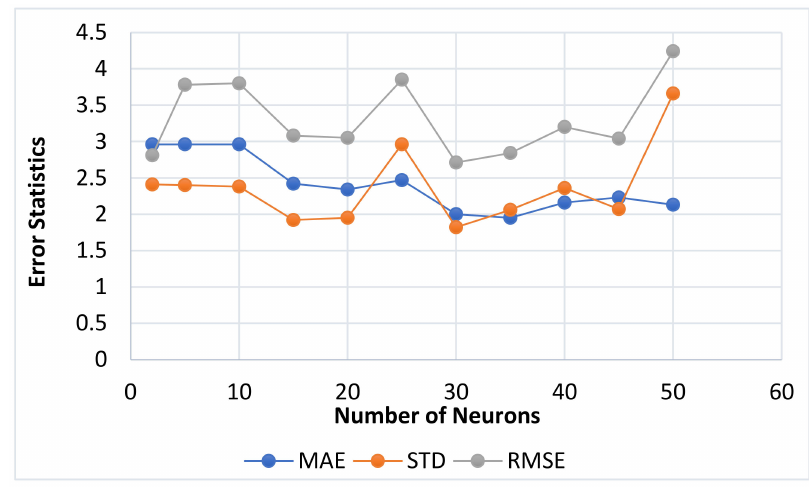
Figure 5. Overall Performance Error Statistics with MAE, STD and RMSE.